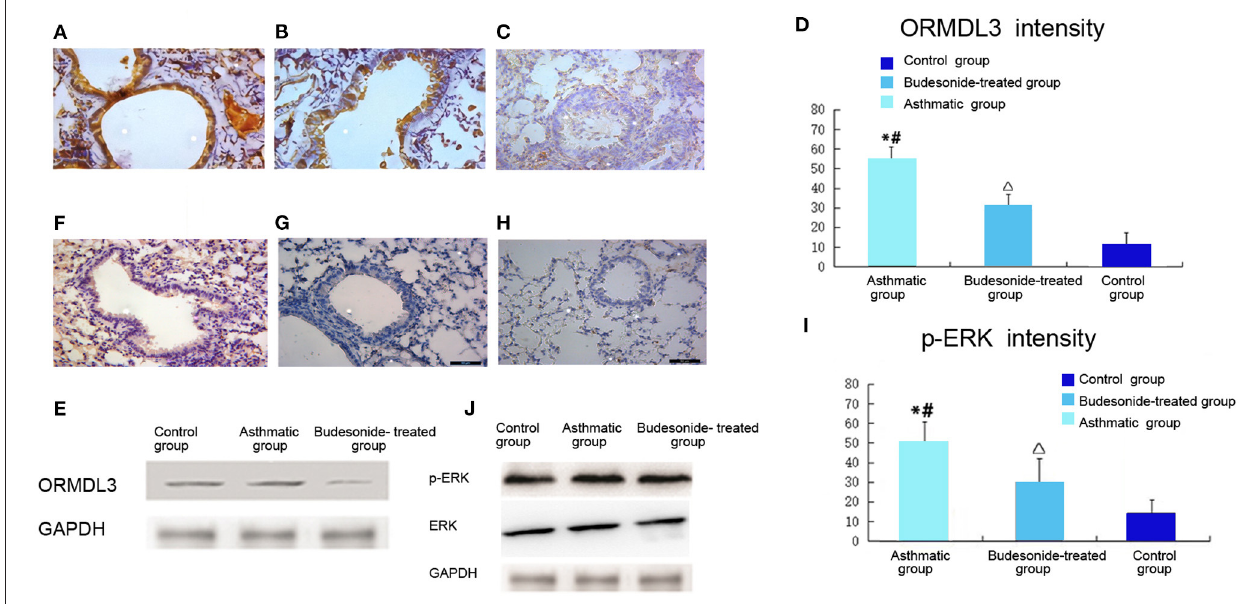
FIGURE 2 | Expression of ORMDL3, p-ERK1/2 increased in asthmatic mice. (A–E) Expression of ORMDL3 in lung tissues. (A) The asthmatic group, (B) the budesonide-treated group, (C) the control group. Magnification, × 200. (D) ORMDL3 protein expression quantified with Image J. (E) ORMDL3 expression with Western blotting. ORMDL3 expression in lung tissues was investigated using immunohistochemistry (A–D) . ORMDL3 was increased in the asthmatic group and decreased in the budesonide-treated group compared with that in the normal control group. * P < 0.01, the asthmatic group vs. the control group. # P < 0.01, the asthmatic group vs. the budesonide-treated group. N P < 0.01, the budesonide-treated group vs. the control group. (F–J) Expression of p-ERK in lung tissues (F) The asthmatic group, (G) the budesonide-treated group, (H) the control group. Magnification, × 200. (I) p-ERK protein expression was quantified with Image J. (J) p-ERK expression with Western blotting. Expression of p-ERK protein in lung tissues was investigated using immunohistochemistry (F–I) . p-ERK expression was increased in the asthmatic group compared with that in the control group and decreased in the budesonide-treated group. * P < 0.01, the asthmatic group vs. the normal control group; # P < 0.01, the asthmatic group vs. the budesonide-treated group; N P < 0.01, the budesonide-treated group vs. the normal control